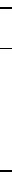
Table 3. Composition of the sensing/dielectric solution for the different sensing elements.